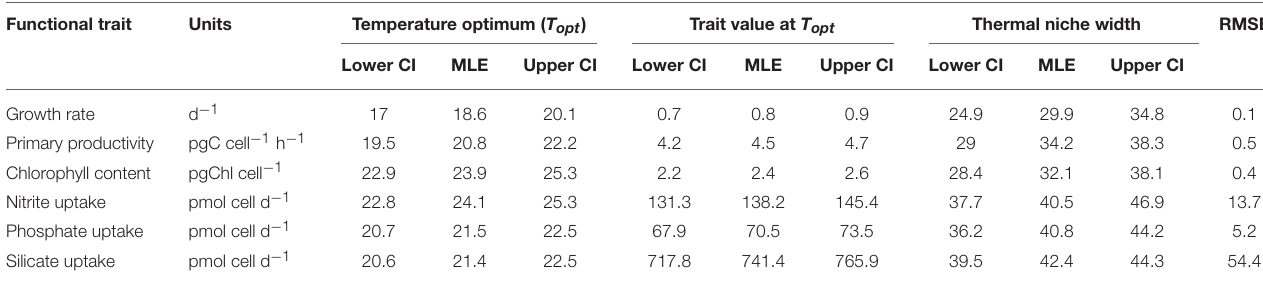
TABLE 1 | Estimated thermal performance curve parameters and associated uncertainty calculated from parametric bootstrapping for each functional trait fitted using Equation 1; thermal optimum T opt , trait value at thermal optimum and thermal niche width. Functional trait